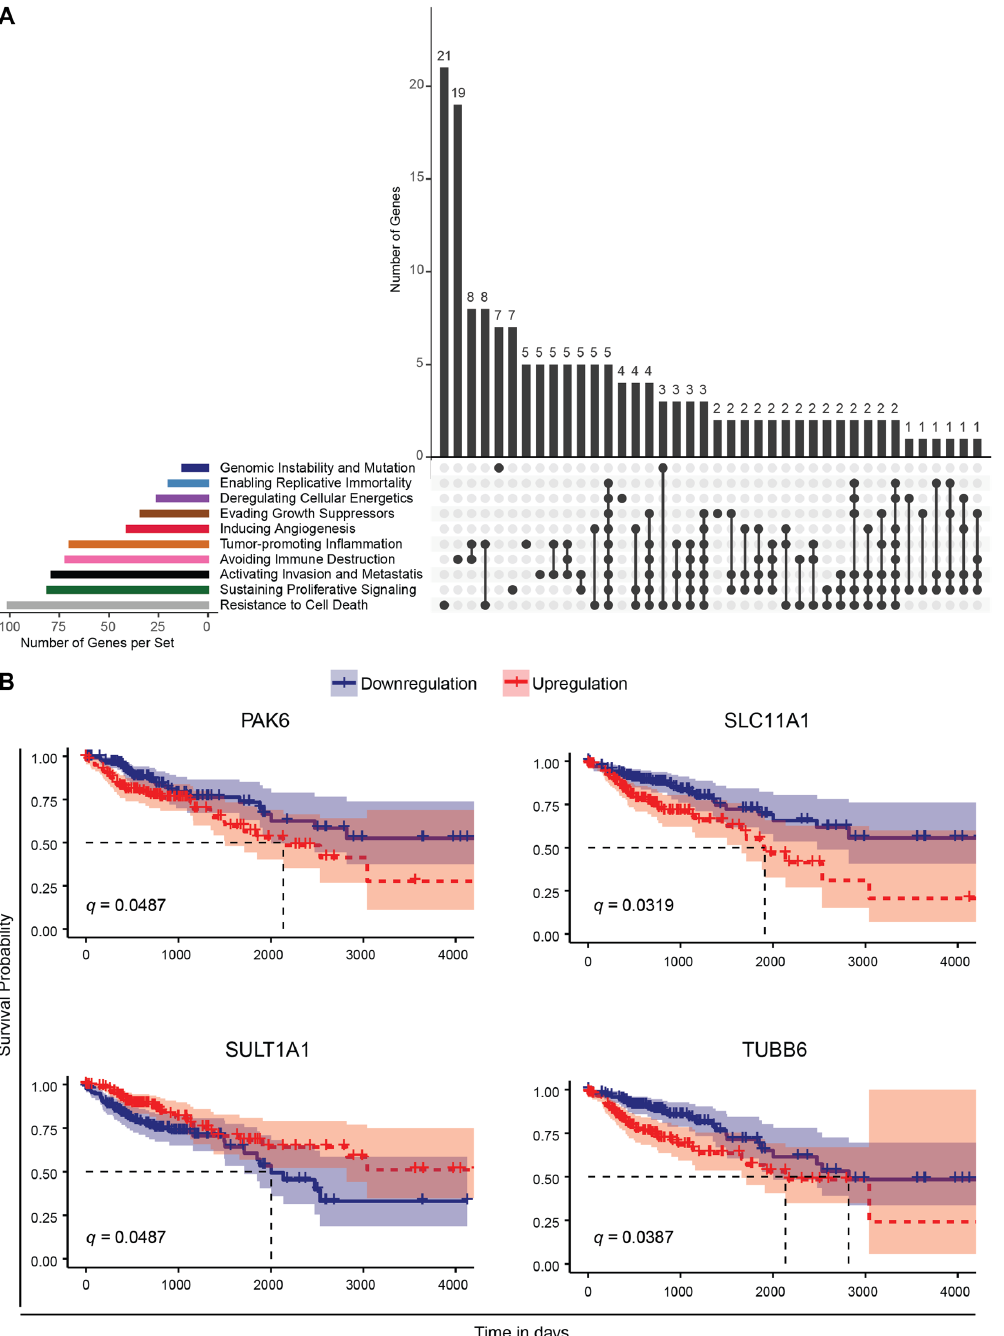
Figure 8. Correlation of genes resulting from the analysis with CRC cell lines and the cohort of IPD patients, with cancer hallmarks and survival in a colon adenocarcinoma cohort. ( A ) The plot depicts the intersection of cancer-hallmarks-related genes (retrieved from the CHG database [56]) and relevant genes highlighted by our analysis (Table S11). The colour coded bar plots ( left ) indicate the number of genes related to a particular cancer hallmark. The genes found to be associated with more than one hallmark are indicated with connecting lines ( right ). The number of unique genes and genes associated